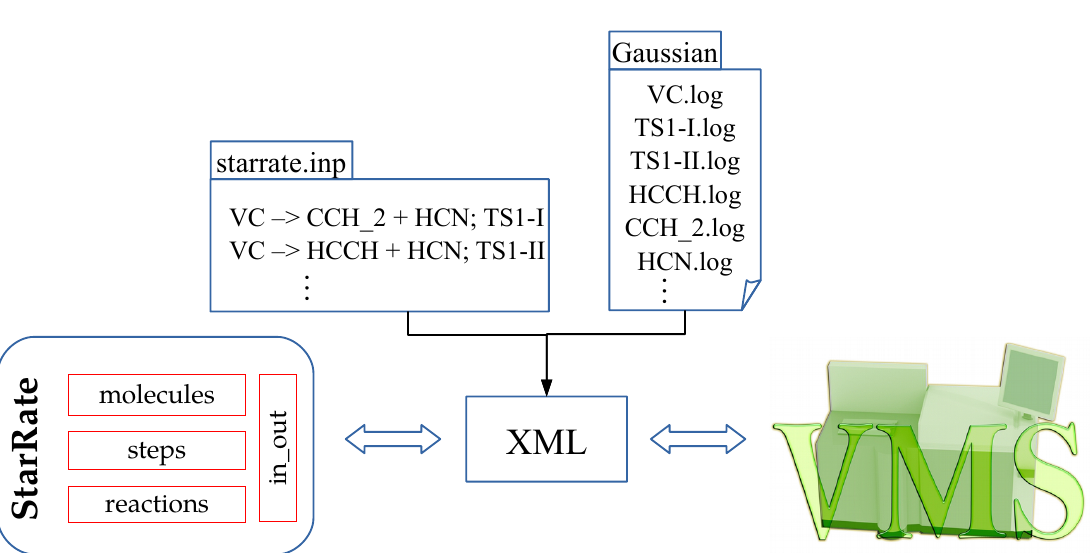
Figure 1. Diagram showing the interoperability between electronic-structure calculations, StarRate, and Virtual Multifrequency Spectrometer (VMS) through a dedicated hierarchical data structure XML interface (see Figure